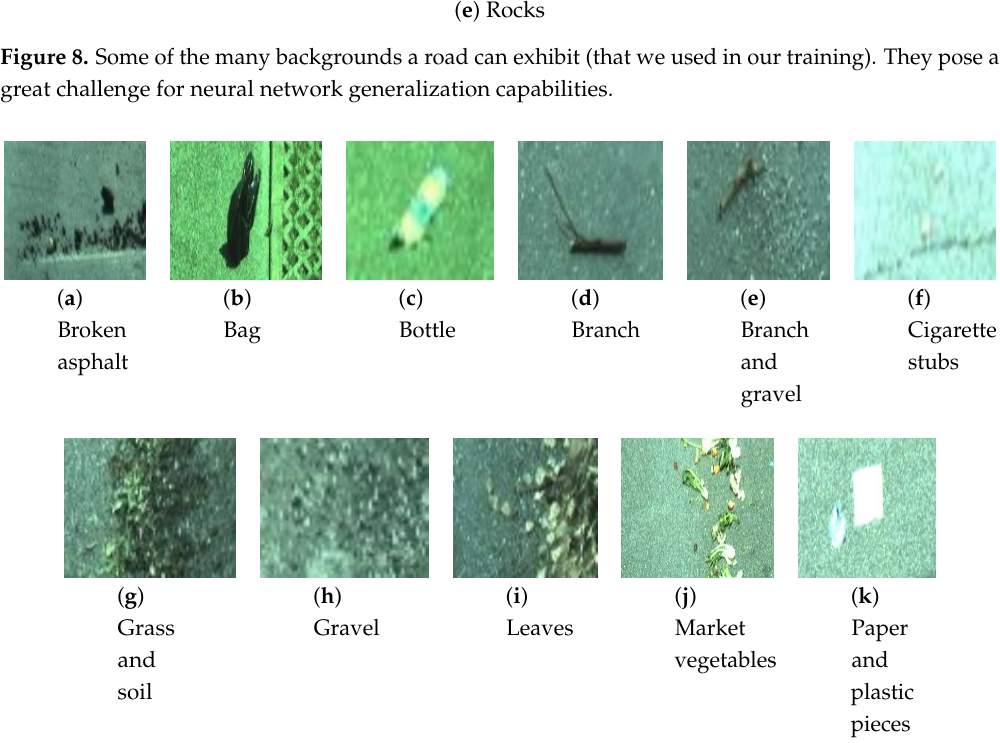
Figure 9. Typical kinds of urban trash to be detected by a cleaning